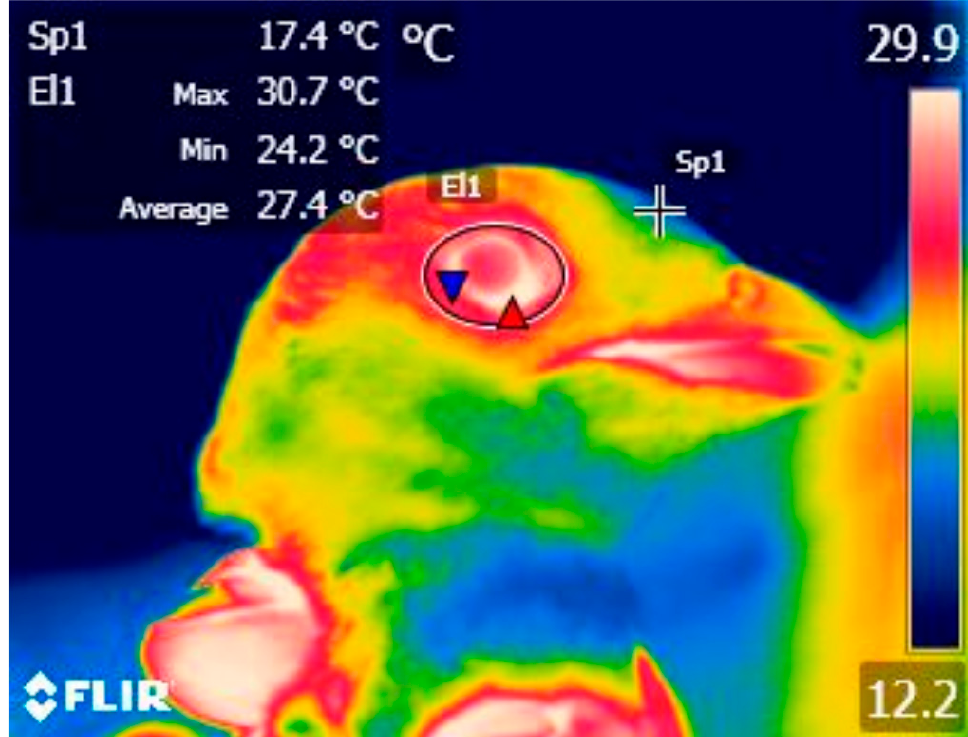
Figure 1. Example of thermal image processed in FLIR Tools+ software (FLIR Systems Inc., Wilsonville, OR, USA). Red and blue triangles indicate maximal and minimal temperature (°C), respectively, measured in the eye-region (delineated by a drawing tool ellipse). Sp1, El1 – the temperature measurement at the point and within ellipse, respectively, summarized in the top-left of the figure.